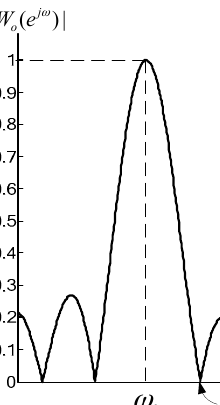
Figure 3. An example of the magnitude response of the optimum ANC filter, | ( )| j single-tone primary noise.